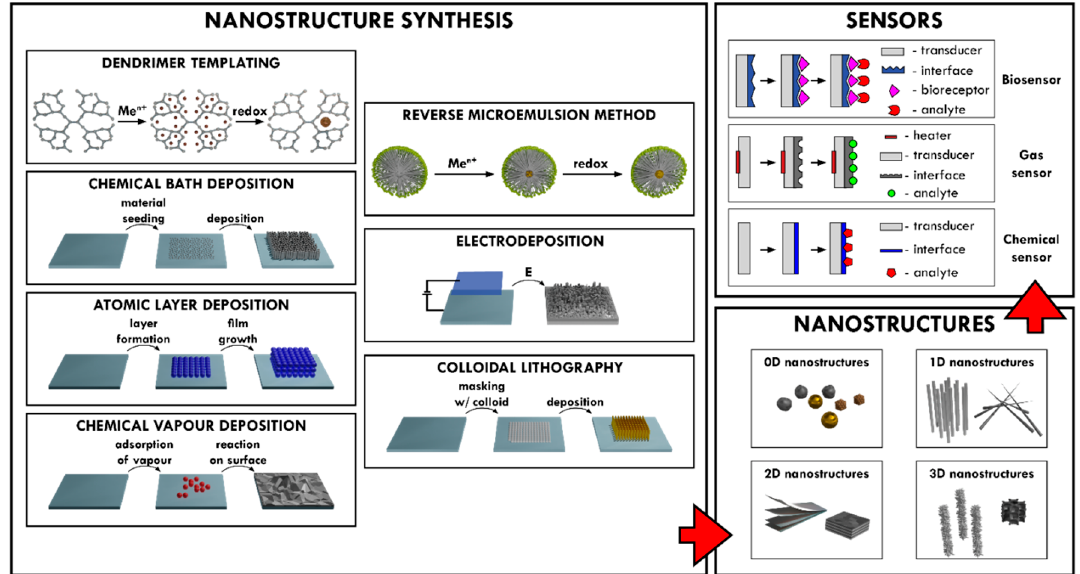
Figure 1. Synthesis methods of various nanostructures and their application in different sensors design.